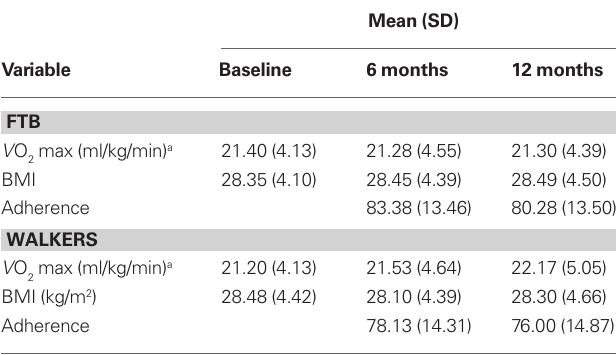
Table 2 | Fitness, BMI, and adherence for exercise